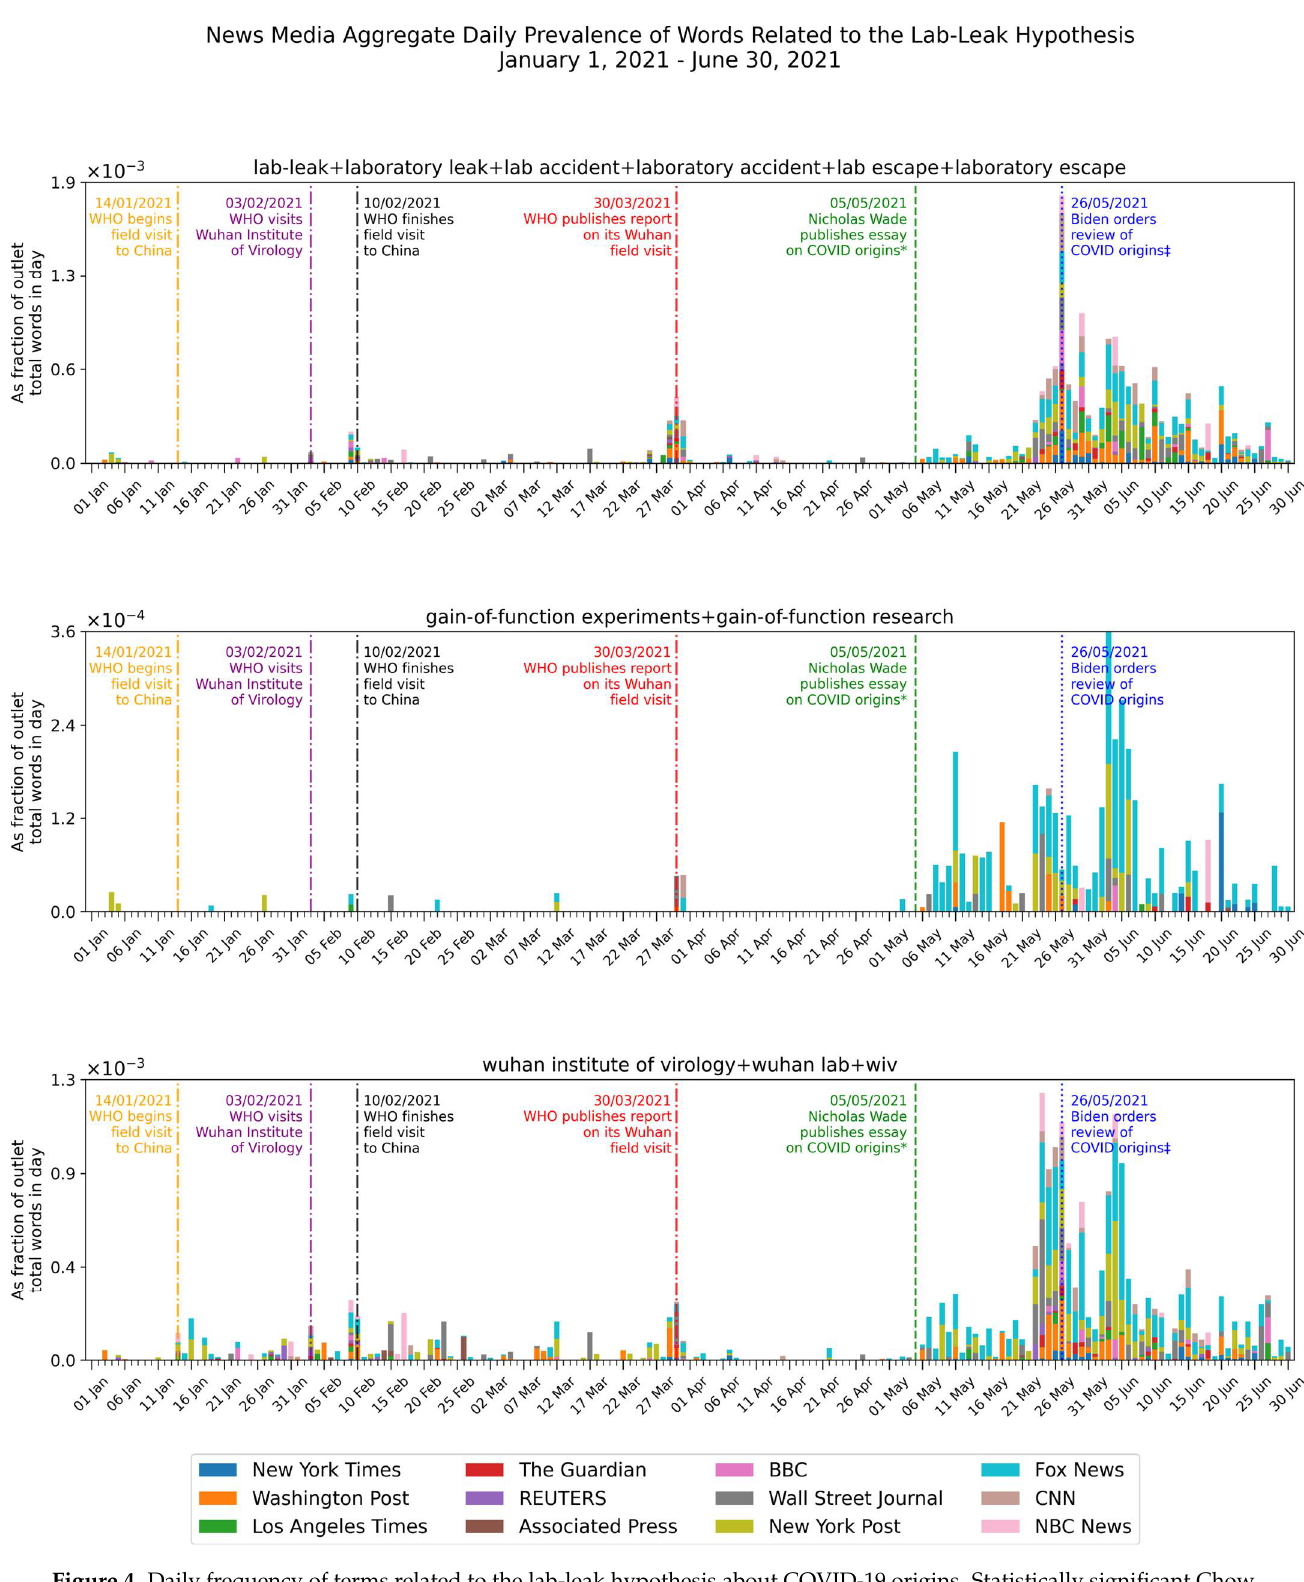
Figure 4. Daily frequency of terms related to the lab-leak hypothesis about COVID-19 origins. Statistically significant Chow tests and paired t -tests of overall prevalence ( p < 0.05, Bonferroni corrected for multiple comparisons) prior to and post each vertical line event are indicated with the ‡ and * symbols, respectively.